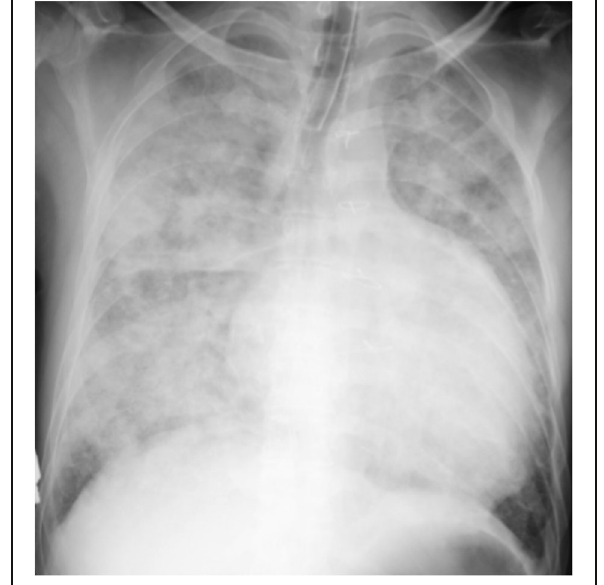
Table 1 Perioperative echocardiographic and cardiac catheterization parameters